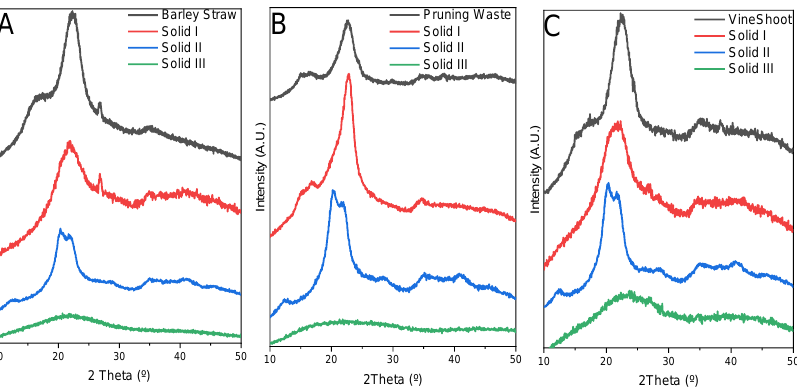
Figure 2. XRD profiles of the original biomass, Solid I, Solid II, and Solid III. (( A ) Barley straw; ( B ) pruning waste; ( C ) vine shoots).